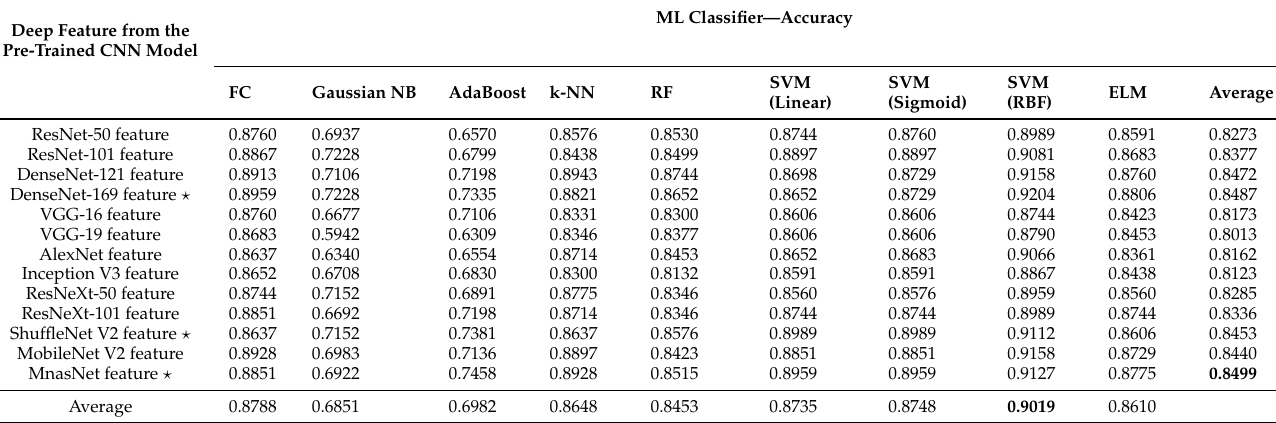
Table 6. Accuracies of pre-trained CNN models with ML classifiers on BT-large-4c dataset ( (cid:63) : top-3 features based on average